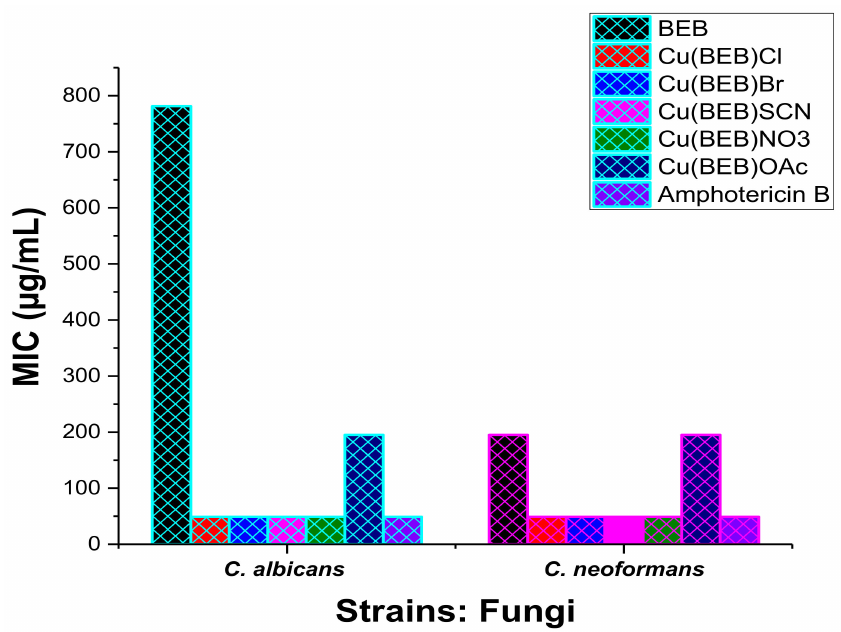
Figure 8. Antifungal activity (MICs) of the Schiff base (BEB) and its Cu(II)